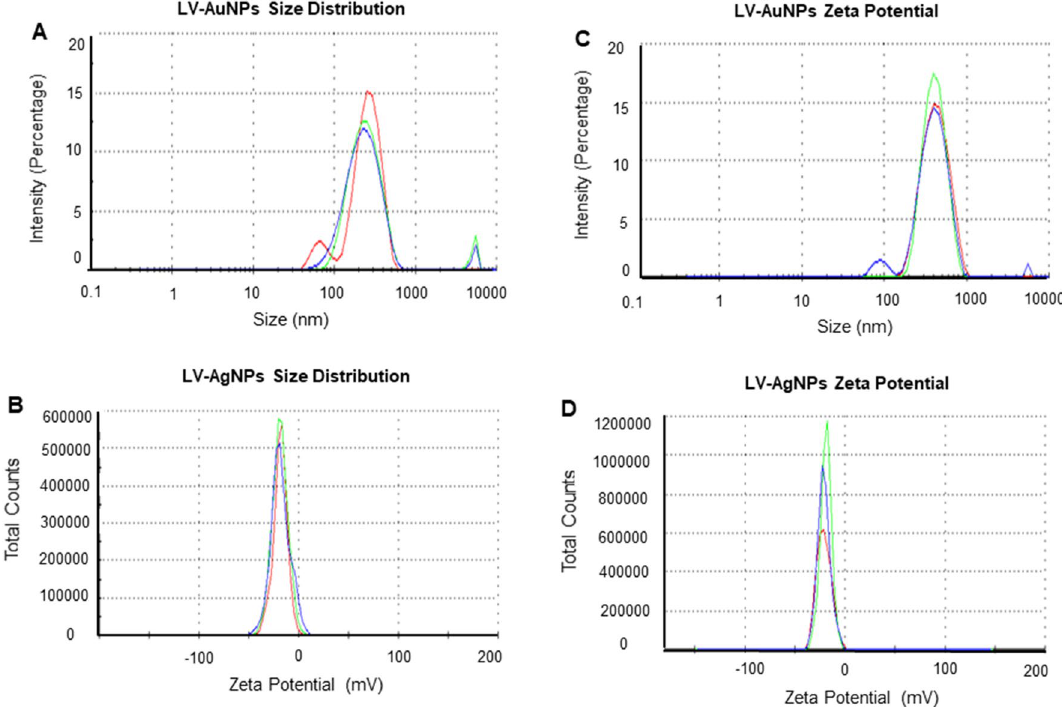
Figure 4. Dynamic light scattering analysis of LV-AuNPs and LV-AgNPs. (A) LV-AuNPs distribution concerning size and intensity (B) LV-AgNPs distribution concerning size and intensity. (C) Zeta potential of LV-AuNPs and (D) LV-AgNPs, representing highly negative surface charge.